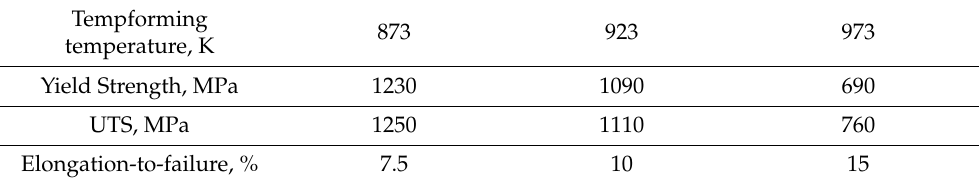
Table 2. Yield strength, UTS and total elongation after tempforming at different temperatures.